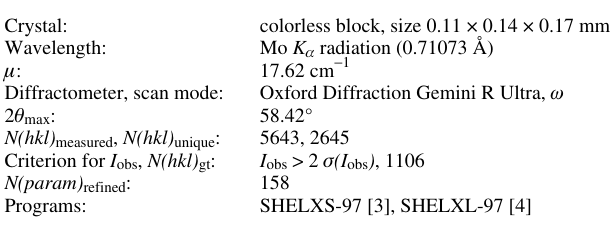
Table 1. Data collection and handling.